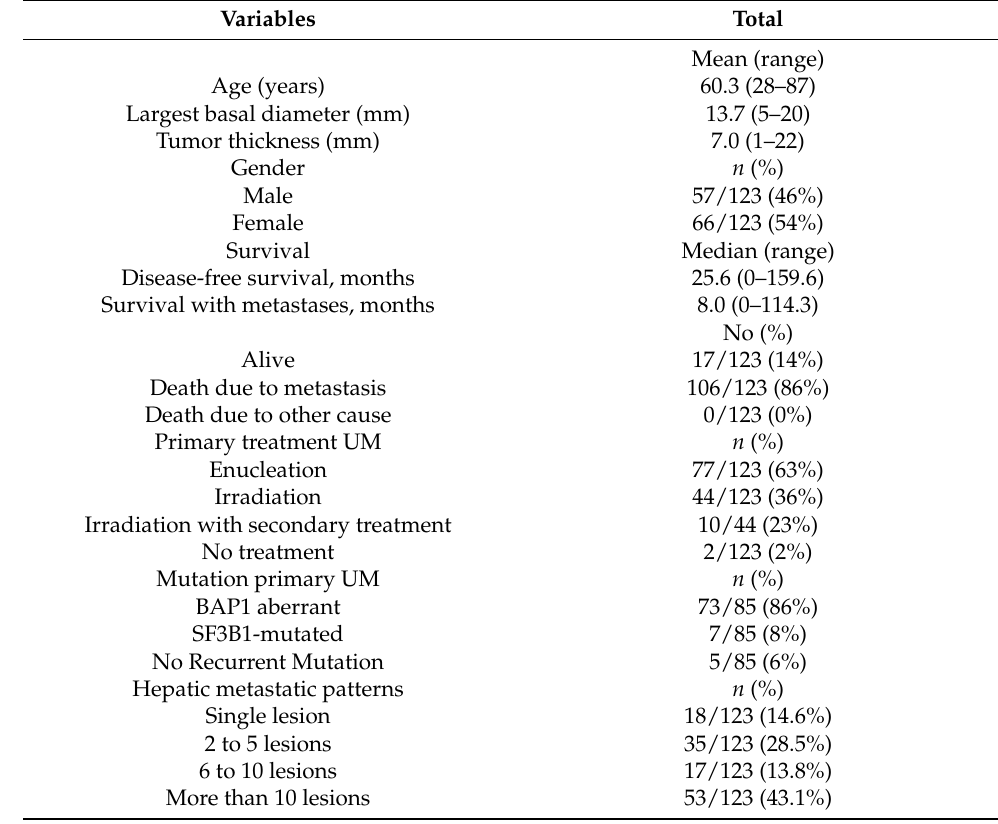
Table 1. Clinical and genetic features of the cohort ( n =